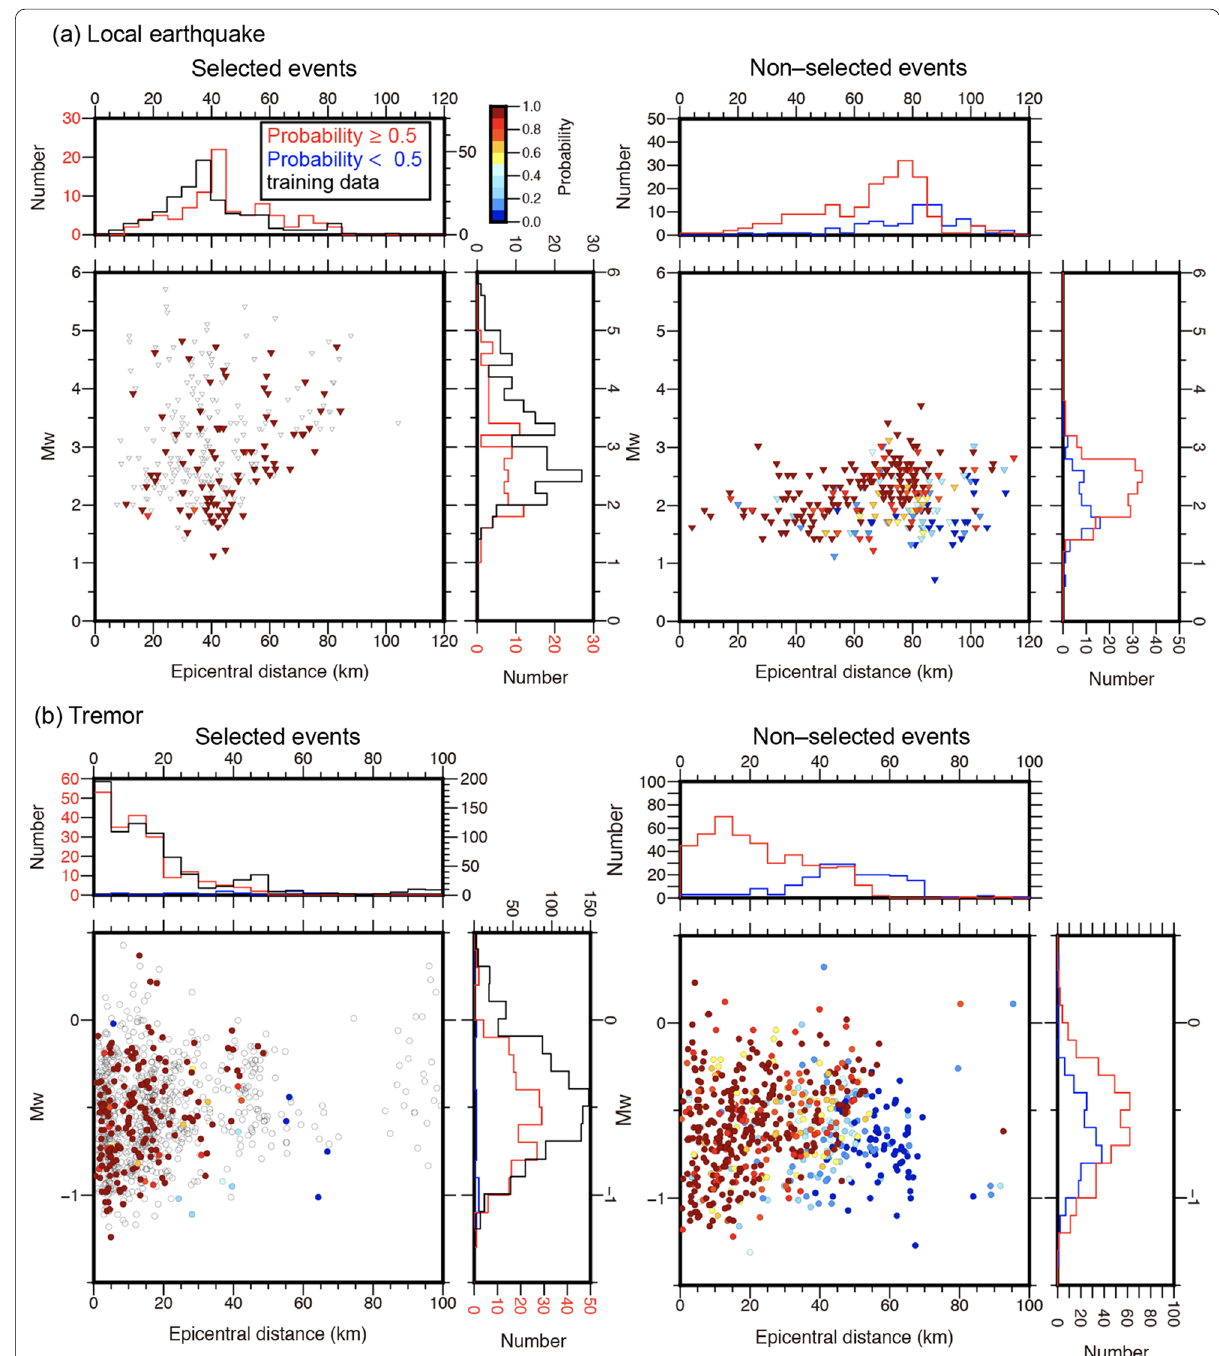
Fig. 4 a M w —epicentral distance plot for the local earthquakes, which are color-coded by their output probabilities, in the selected (training) and non-selected datasets. The black line shows the training dataset for the local earthquakes. b M w —epicentral distance plot for the tectonic tremors, which are color-coded by their output probabilities, in the selected and non-selected datasets. The black, red, and blue histograms indicate the training dataset, high-probability ( 0.5) events, and low-probability (< 0.5) events, ≥